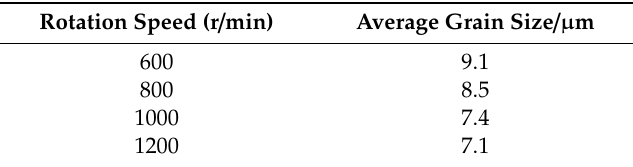
Table 3. Grain size in SZ at di ff erent rotational speeds.